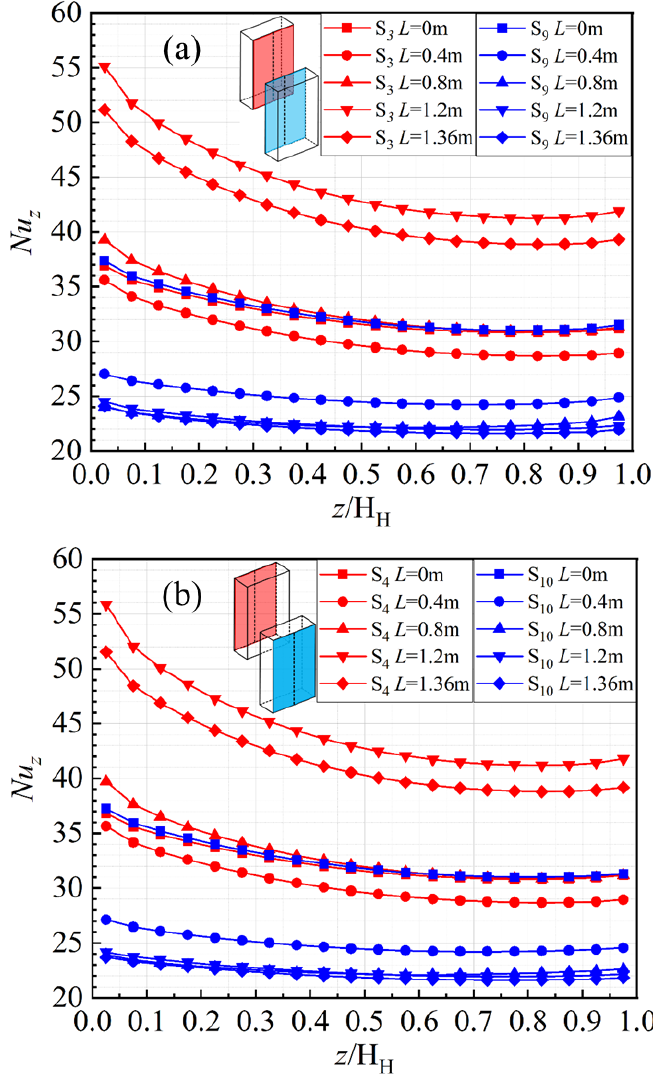
Figure 10. The distribution of local Nusselt number of the side walls of the heat sources with different L . ( a ) S 3 and S 9 . ( b ) S 4 and S 10 .